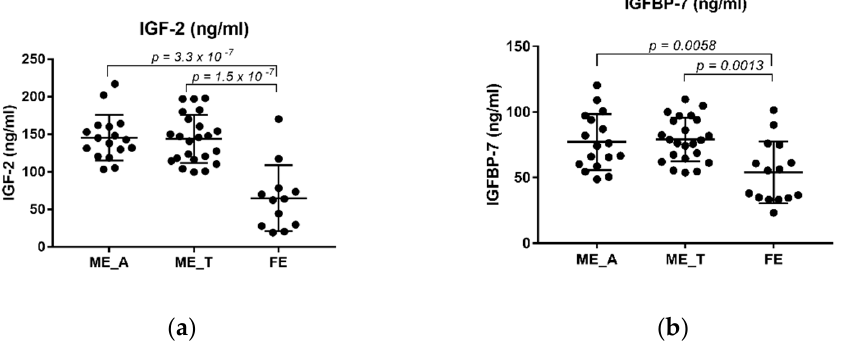
Figure 3. Plasma levels of IGF-2 (ng/mL) and IGFBP-7 (ng/mL) in SZ patients. ( a ) Levels of IGF-2 are significantly downregulated in the FE group when compared against both ME_A and ME_T; ( b ) Levels of IGFBP-7 are significantly downregulated in the FE group when compared against both ME_A and ME_T. Tukey’s multiple comparison test was applied, and significant p -values are shown in each graph. FE: First Episode drug-naïve patients, ME: multiple or chronic patients,